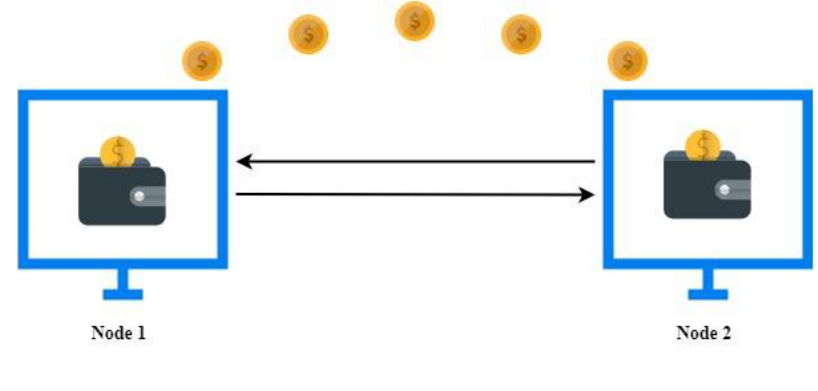
Figure 3. Bitcoin